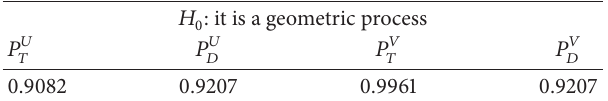
Table 1: 𝑃 values of